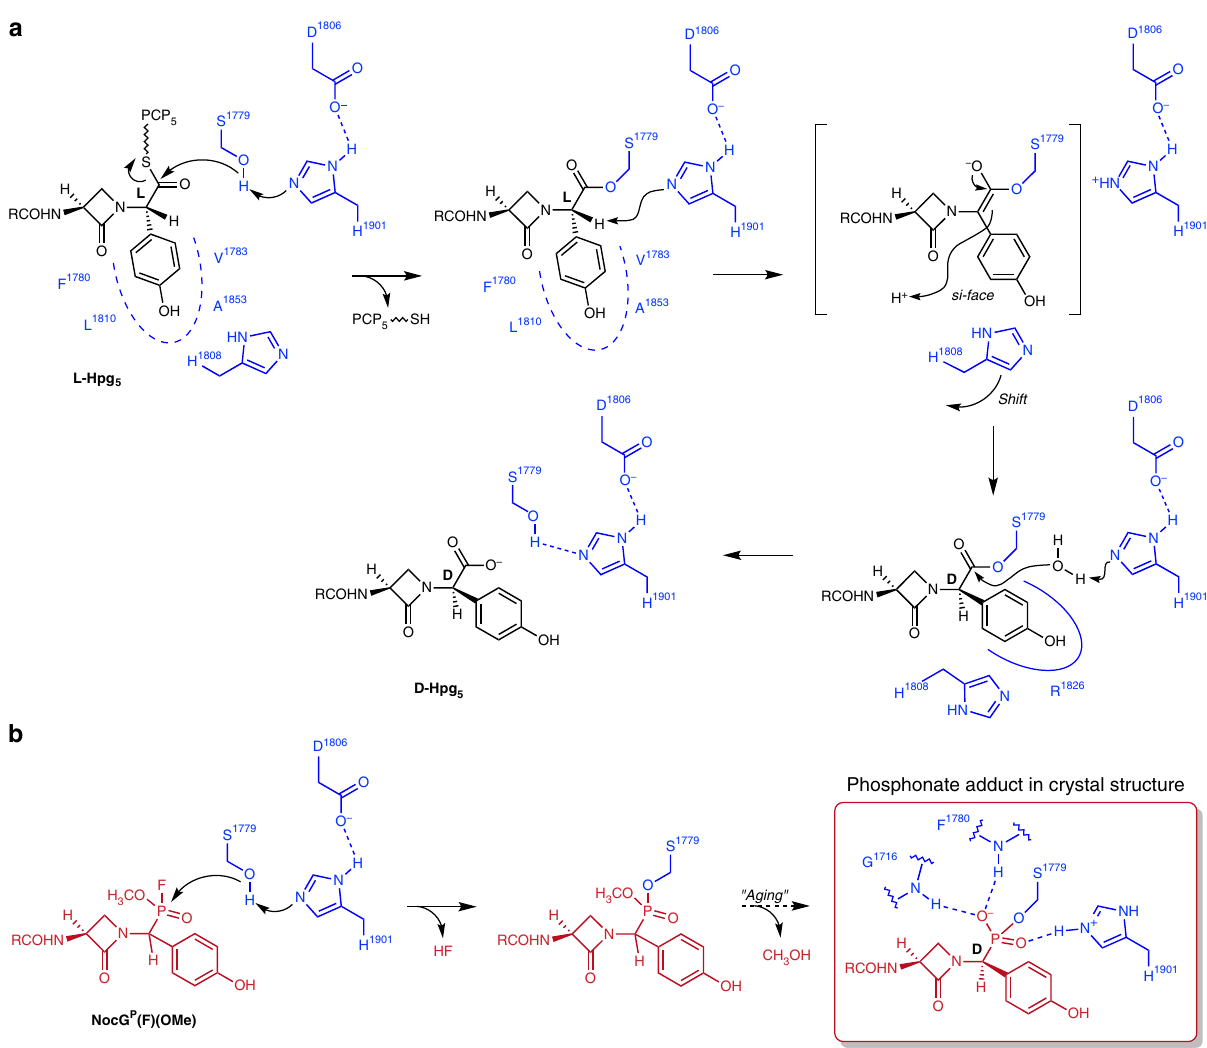
Fig. 8 Proposed NocTE catalytic mechanism. a The proposed sequence of transthiolation, epimerization, and hydrolysis steps catalyzed by NocTE is depicted. The residues that comprise the binding pockets for the L-Hpg and D-Hpg are indicated with the dashed and solid curves, respectively. The movement of the His1808 side chain that accompanies epimerization is also represented. b Illustration of attack and aging of the FP probe. The boxed structure is observed in the crystal and represents the species directly above it in ( a ), highlighting how the phosphonate oxygens mimic the oxyanion